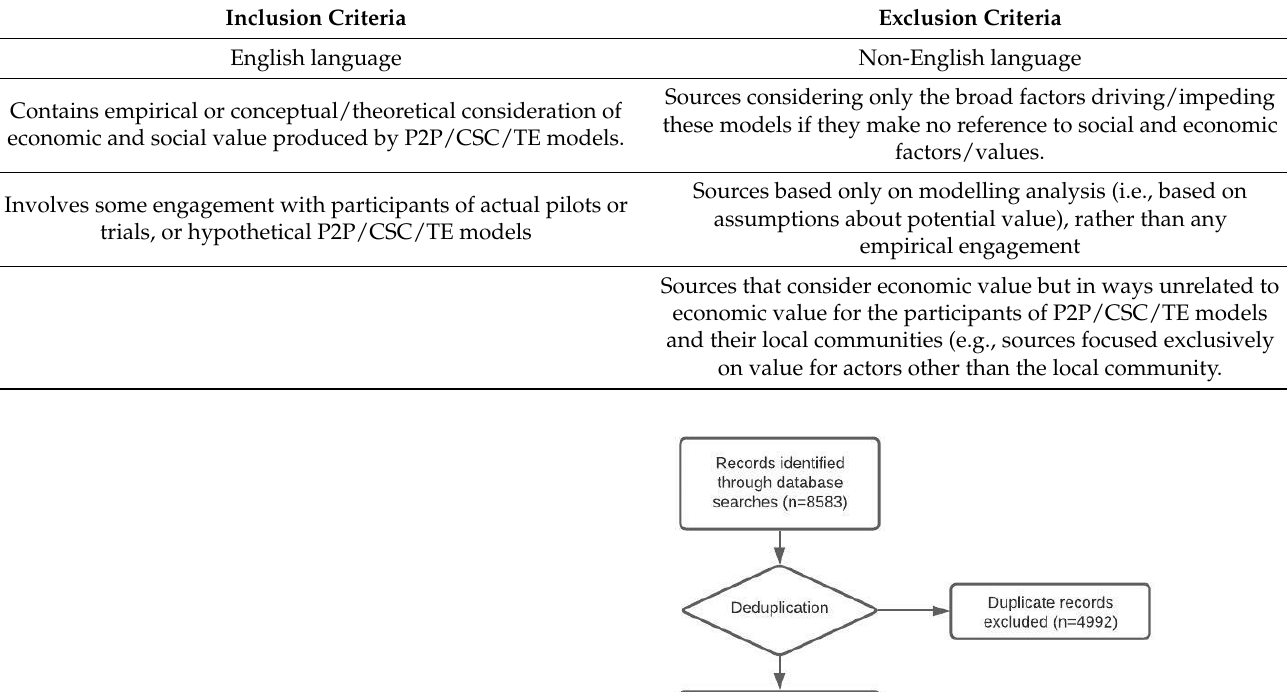
Table 2. Inclusion and exclusion criteria.